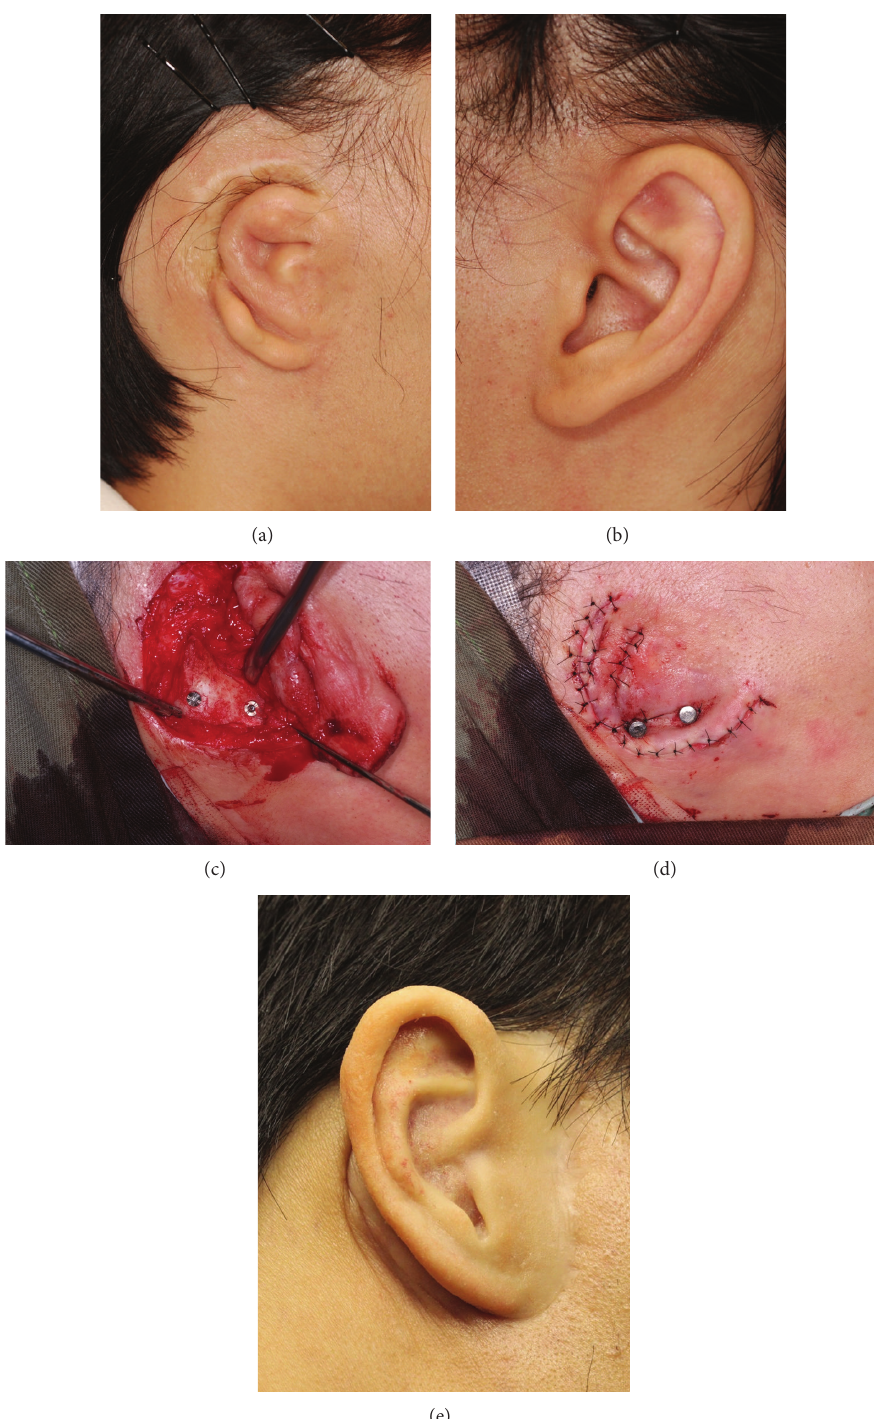
Figure 1: Case illustration of a patient with microtia. (a) Patient’s right ear showing microtia. (b) Patient’s left ear showing normal shaped ear. (c) Two implants were placed into the mastoid bone. (d) Wound closure with healing abutment exposed. (e) Patient’s right ear showing the auricular